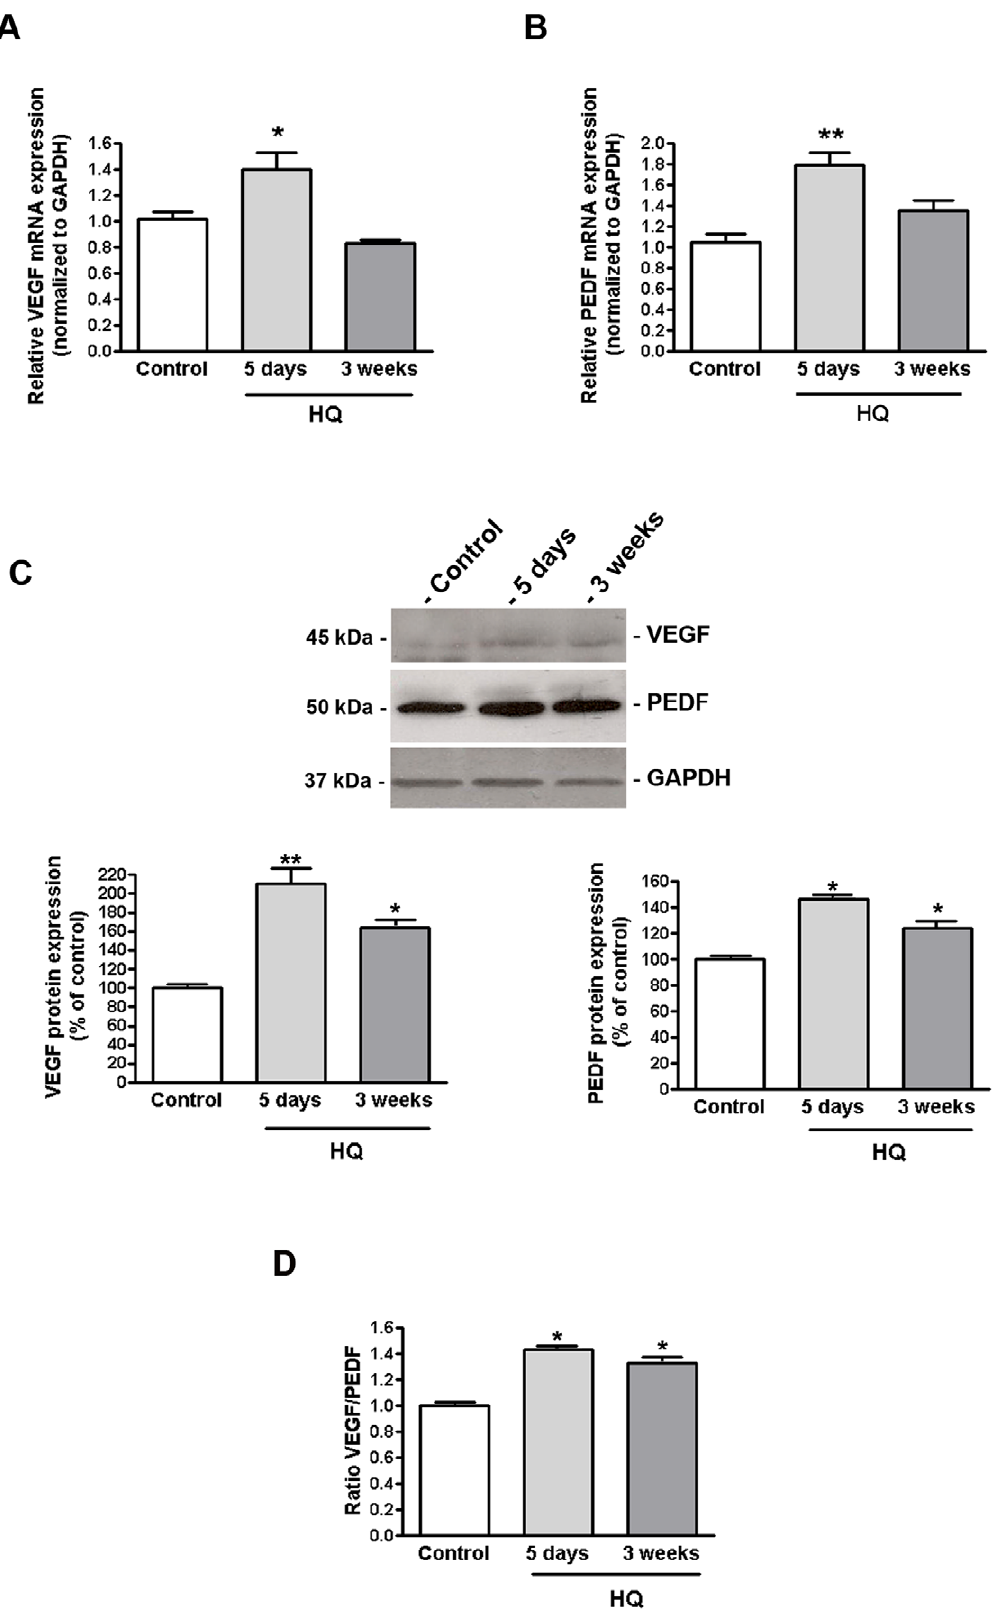
Figure 7. VEGF-PEDF balance is altered in RPE/choroids from mice exposed to HQ. ( A ) VEGF and ( B ) PEDF mRNA expression in response to HQ-induced oxidative injury. Total RNA was extracted from microdissected RPE/choroid complexes after 5 days and 3 weeks of exposure to HQ in